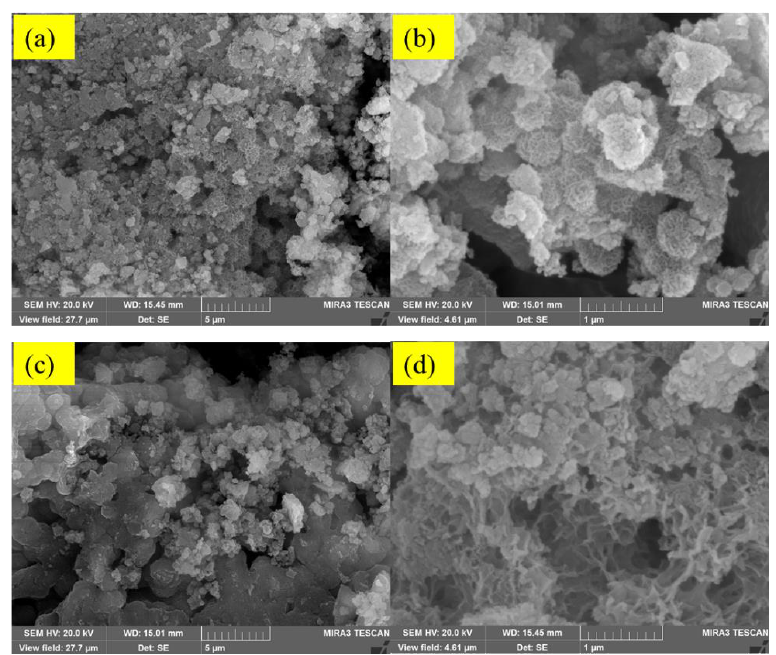
Figure 6. XRD of two kinds of precipitates in catholyte (( a ), precipitate 1, ( b ), precipitate 2). (Refer- ence codes of Ca 5 (PO 4 ) 3 (OH), Ca 3 SiO 5 , Ca 2 (SiO 4 ) and AlPO 4 were 01-086-0740, 00-016-0406, 01-087- 1258, and 01-088-1680, respectively.).